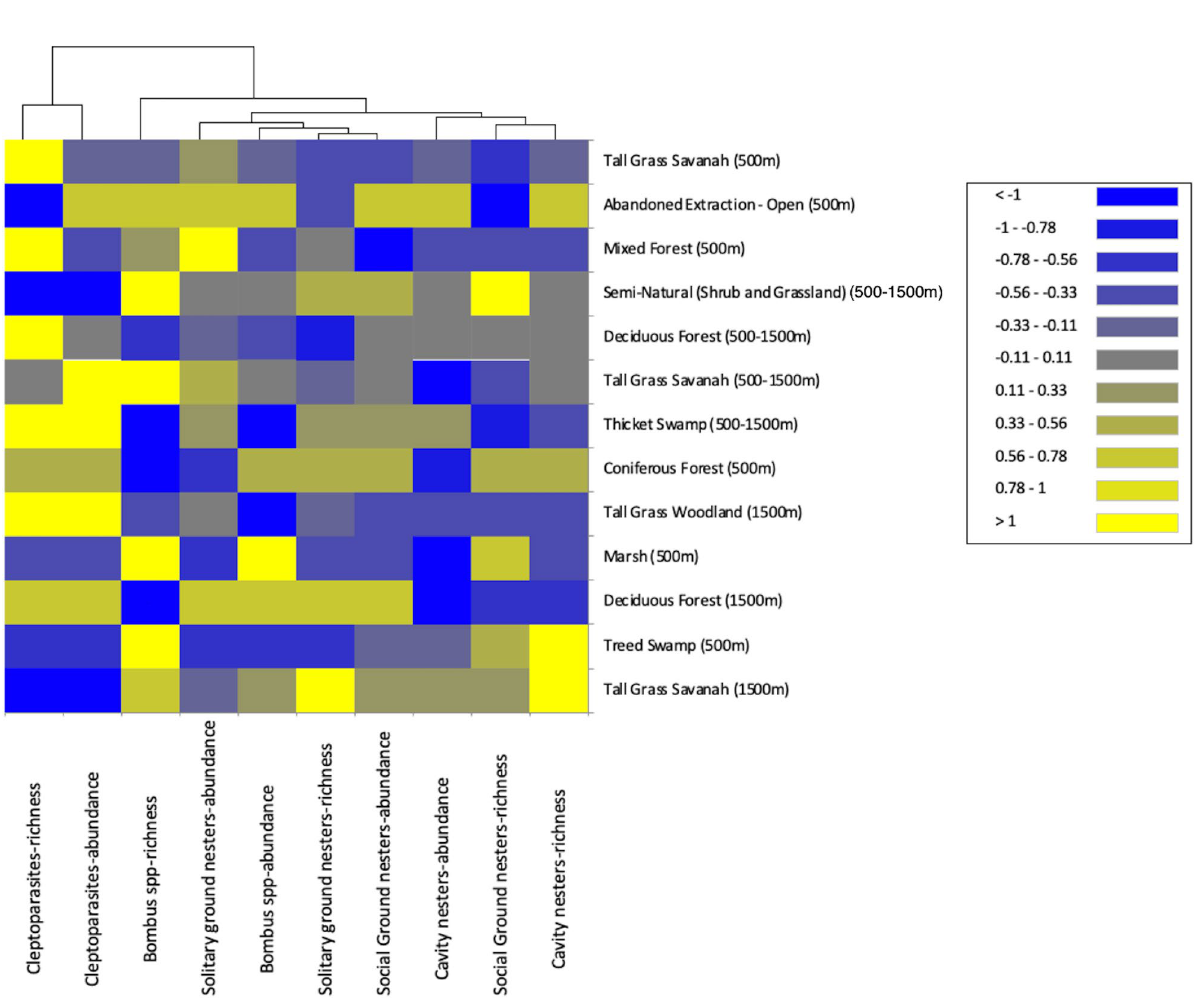
Figure 4. Heat map showing the most important habitat types driving key bee biodiversity metrics (species richness and proportional abundance) of five functional bee guilds: solitary ground nesters, social ground nesters, cavity nesters, bumblebees ( Bombus spp. excluding subgenus Psithryus ), and cleptoparasitic species (including Bombus subgenus Psithryus ) at three spatial scale categories (< 500 m, 500–1500 m, and > 1500 m); lighter shades of yellow indicate most preferred habitat types at different spatial distances, darker shades of blue suggest a less desirable habitat for supporting functional guild species richness and abundance. Black cells indicate the habitat has a neutral impact on bee species richness in the landscape. Habitat similarity is characterized by similar groupings of colours, either among function guilds (horizontal rows) or across spatial distances and habitat types (vertical columns). Forested habitats represented 50 m edges of habitat. This is a filtered version of the overall heat map (Fig. S1) from which habitat types with an interquartile range of < 0.25 of significant β coefficients (habitat types) have been removed. Heat map was produced using XLSTAT v.4.1 63